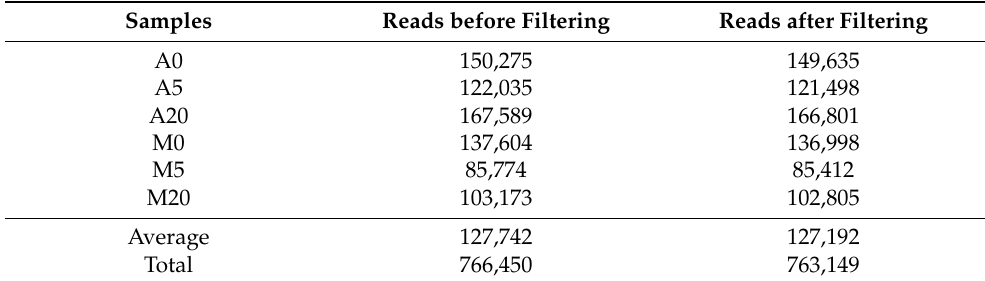
Table 1. Reads per sample before and after the process of trimming and filtering. Samples Reads before Filtering Reads after